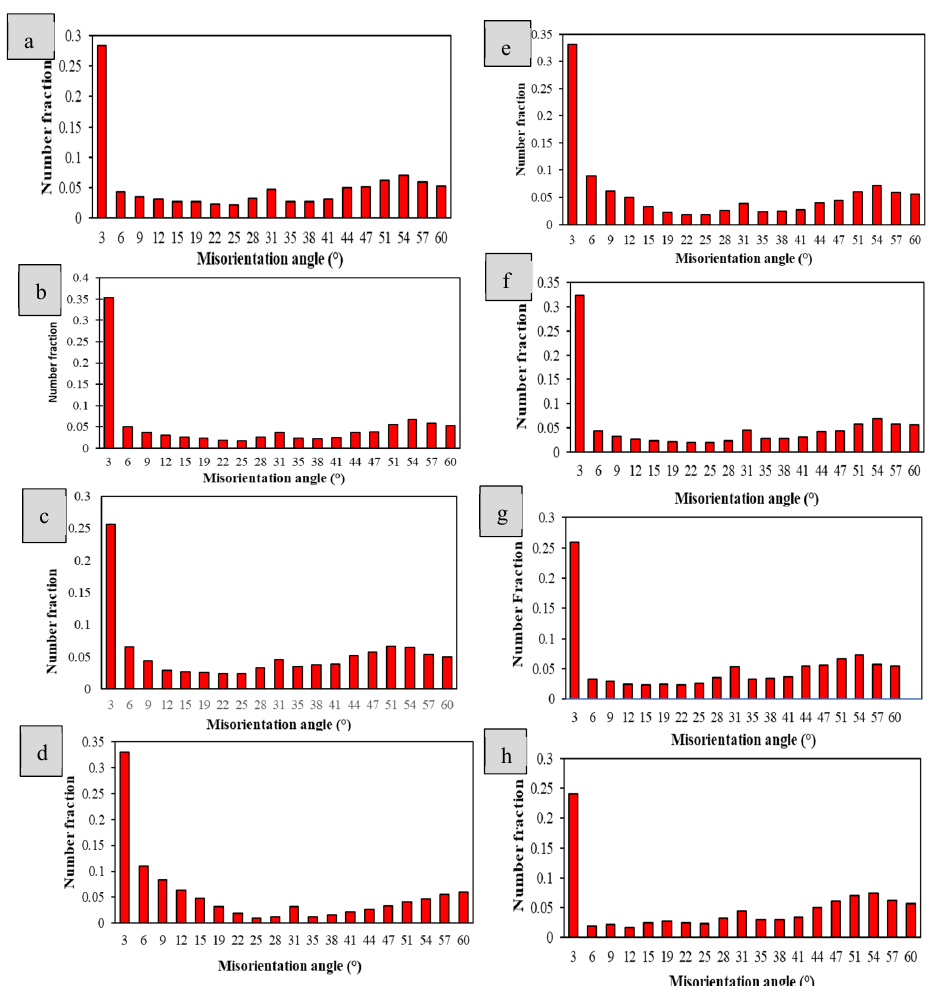
Figure 8. Average grain size distribution of microalloyed steel specimen in unpeened and LSP con- ditions.